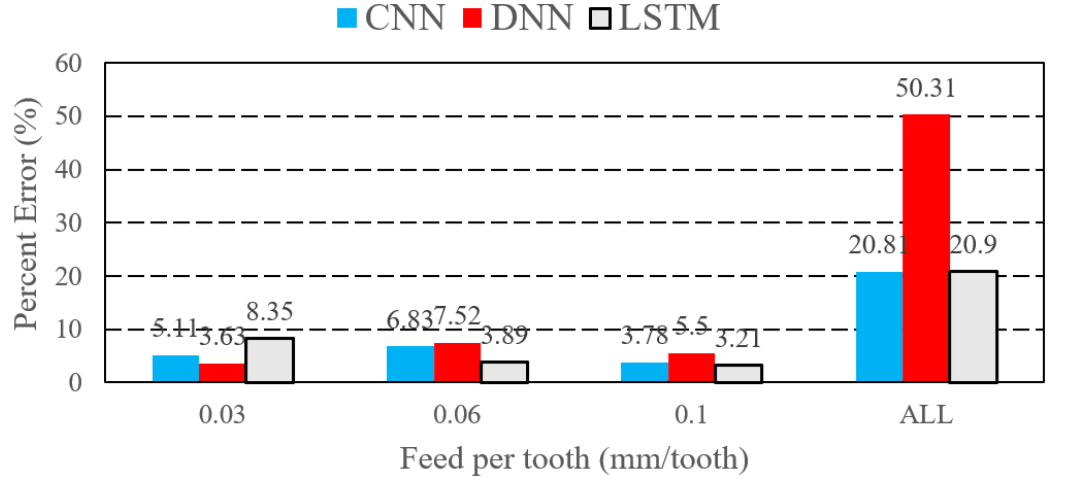
Figure 15. Percent error of roughness prediction.